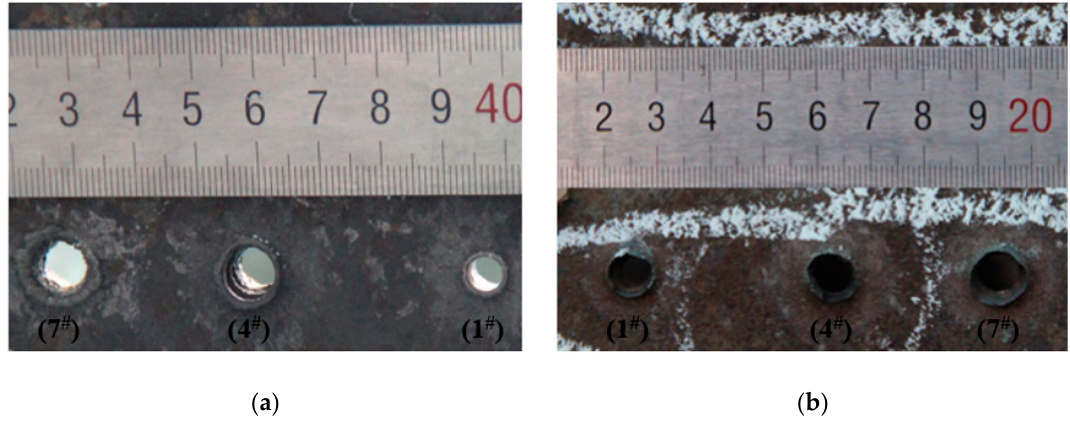
Figure 6. Damage caused to the RHA target plate: ( a ) Front; ( b ) Back.